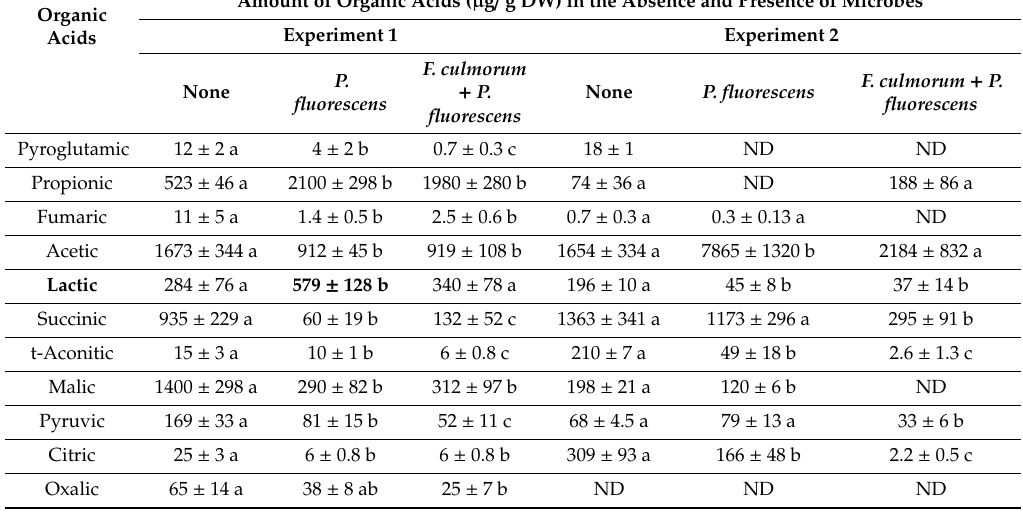
Values in the same experiment with di ff erent letters are significantly di ff erent at p ≤ 0.05 when applying Fisher’s LSD test. Values are means ± standard deviations. ND = not detected. Substances most actively utilized by F. culmorum are marked in bold.